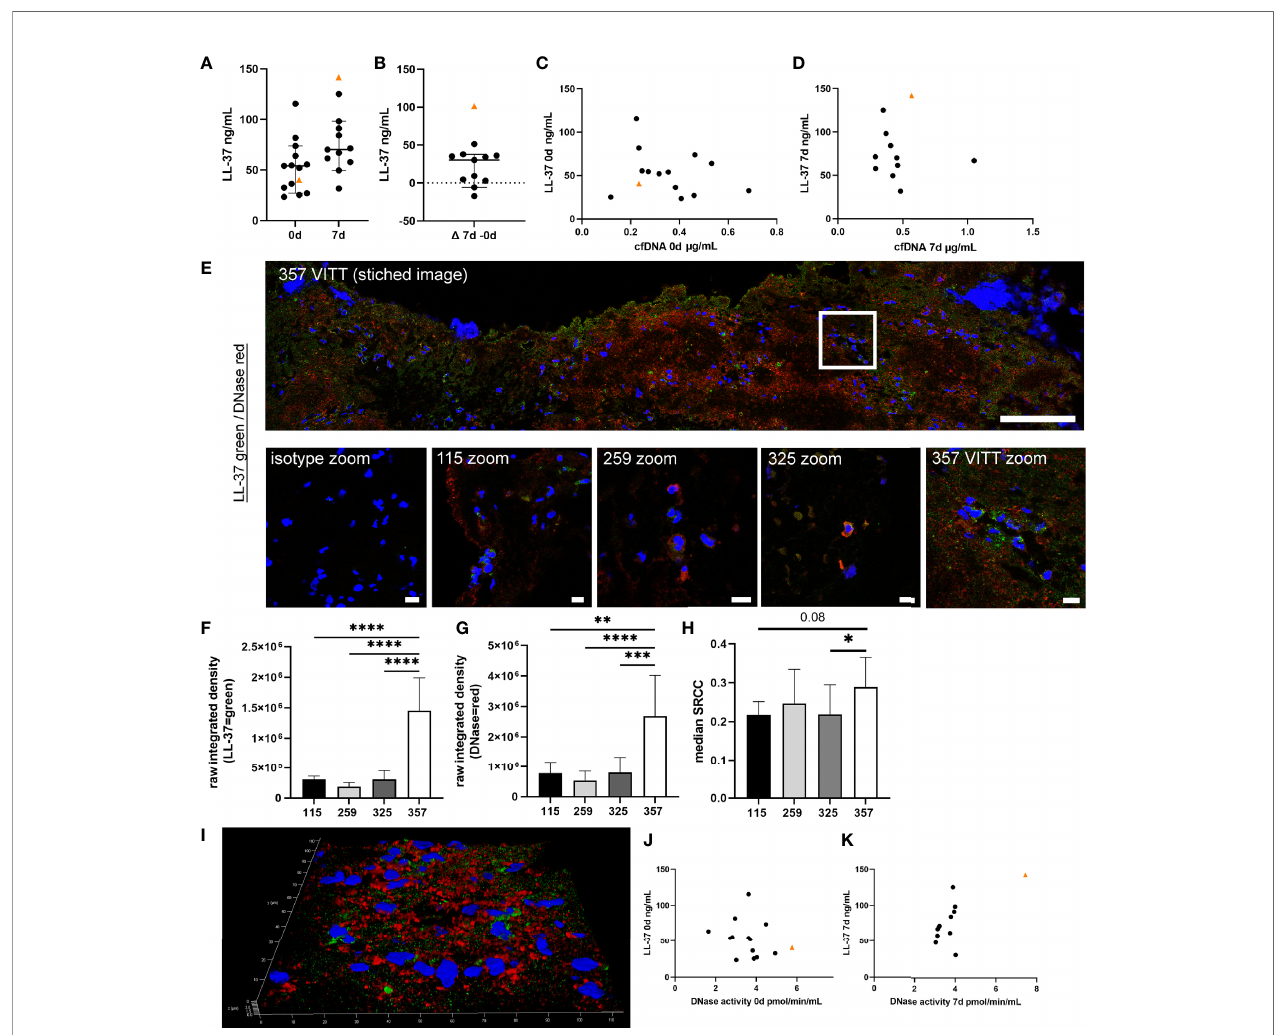
FIGURE 5 | Cationic antimicrobial peptide LL-37, as potential protector of NETs against DNase degradation, is highly increased in VITT-samples. (A, B) LL-37, known to induce as well as bind to NETs and stabilize NETs against DNase degradation, was analyzed in EDTA plasma. All data are presented as scatter plots, black lines depict the median and whiskers depict 95% con fi dence intervals of control values. The VITT-patient is marked as orange triangle. The highest increase of LL-37 over time is detected in the VITT-patient (B) . (C) Values of cfDNA and LL-37 at onset were plotted in one graph. (D) Values of cfDNA and LL-37 at 7d were plotted in one graph. (E) LL-37 (green) and DNase (red) were stained in extracted thrombi of the VITT-patient (357) and three control patients without VITT (115, 259 and 325). Stitched image shows distribution of both markers inside the thrombus of the VITT-patient (scale bar = 100µm). A zoom picture of the white squared area is presented. Microscope settings were adjusted to the presented isotype control and example pictures are presented, scale bar = 10µm. (F, G) The raw integrated density of LL-37 and DNase was measured in randomly selected pictures. Strong LL-37 and DNase signals in the same area were especially identi fi ed in the thrombus of the VITT-patient. All data are presented as mean ± SD. Statistical differences were analyzed by one-way ANOVA, followed by Tukey ’ s multiple comparisons test (**p < 0.01, ***p < 0.001 and ****p < 0.0001) (H) All single images analyzed in (F, G) were investigated for colocalization by calculating SRCC. Statistical differences were analyzed by unpaired on-tailed Student ’ s t-test (*p < 0.05) (I) 3D image of z-stacks (42 sections, 0.13µm steps, total size 5.16µm) from VITT-thrombus was constructed with LAS X 3D Version 3.1.0 software (Leica), scale bar = 10µm. In this area high amounts of obviously extracellular DNase and LL-37 were detected. (J) Values of DNase activity and LL-37 at onset were plotted in one graph. (D) Values of DNase activity and LL-37 at 7d were plotted in one